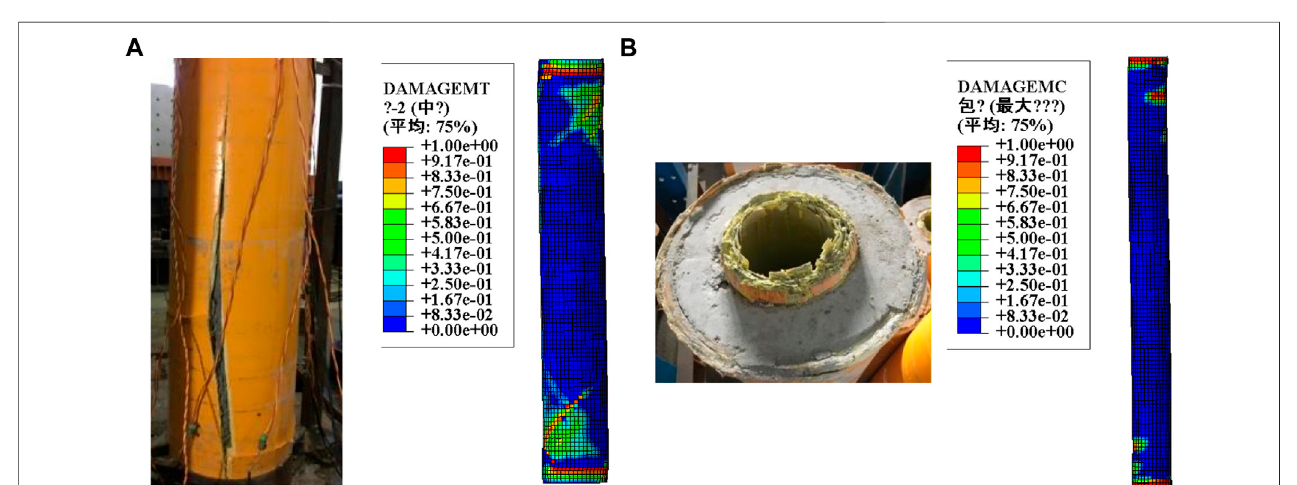
FIGURE 9 | Comparison of failure modes. (A) Comparison of outer tube. (B) Comparison of inner tube.